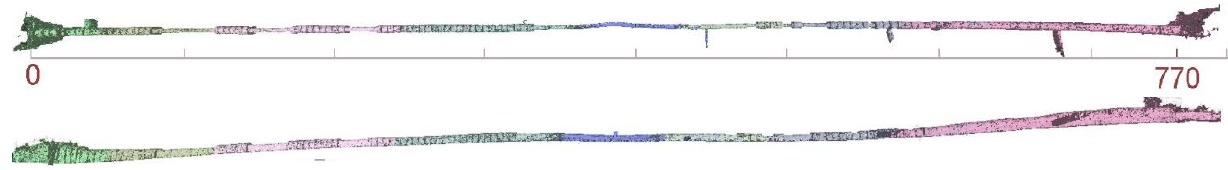
Figure 7: Plan and elevation of the final point